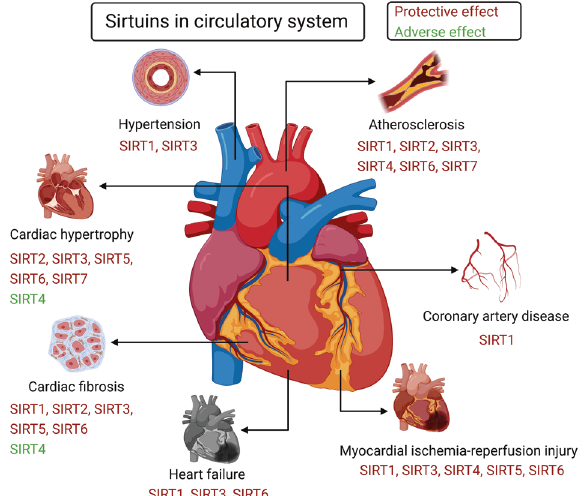
Fig. 10 The roles of SIRTs in circulatory system. SIRT1, SIRT3 and SIRT6 play protective roles in CVDs, such as cardiac fi brosis,